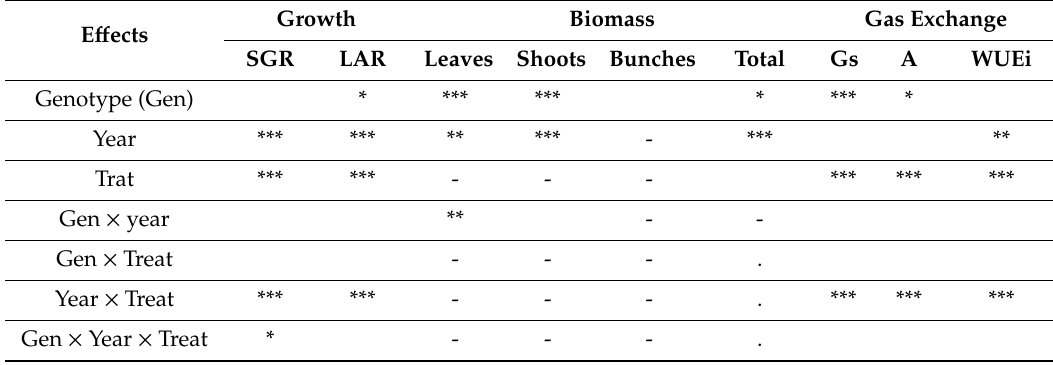
Table 2. Three-Ways ANOVA performed for genotype × years × treatment as main e ff ect on growth, biomass, and gas exchange parameters, and their interaction. E ff ects